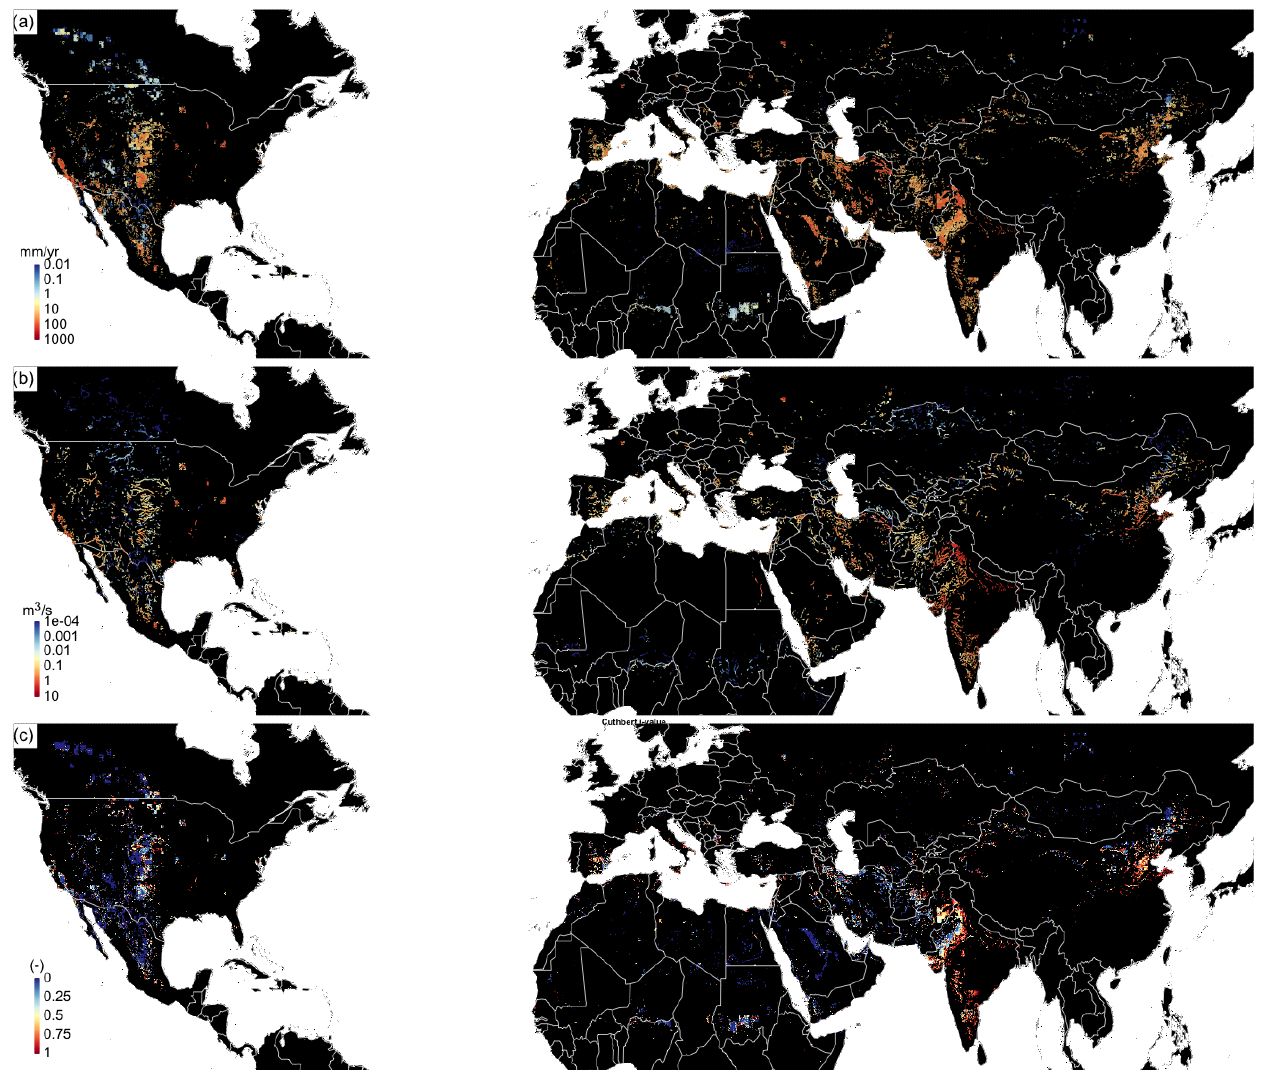
Figure 7. Results for the areas with unstable withdrawal rates ( q > q crit ); (a) groundwater-level decline rate (mmyr − 1 ); (b) equilibrium reduction of discharge (m 3 s − 1 ); (c) fraction of capture (–); black areas are areas without groundwater withdrawal, with stable groundwater withdrawal or with negligible values ( < 10 − 4